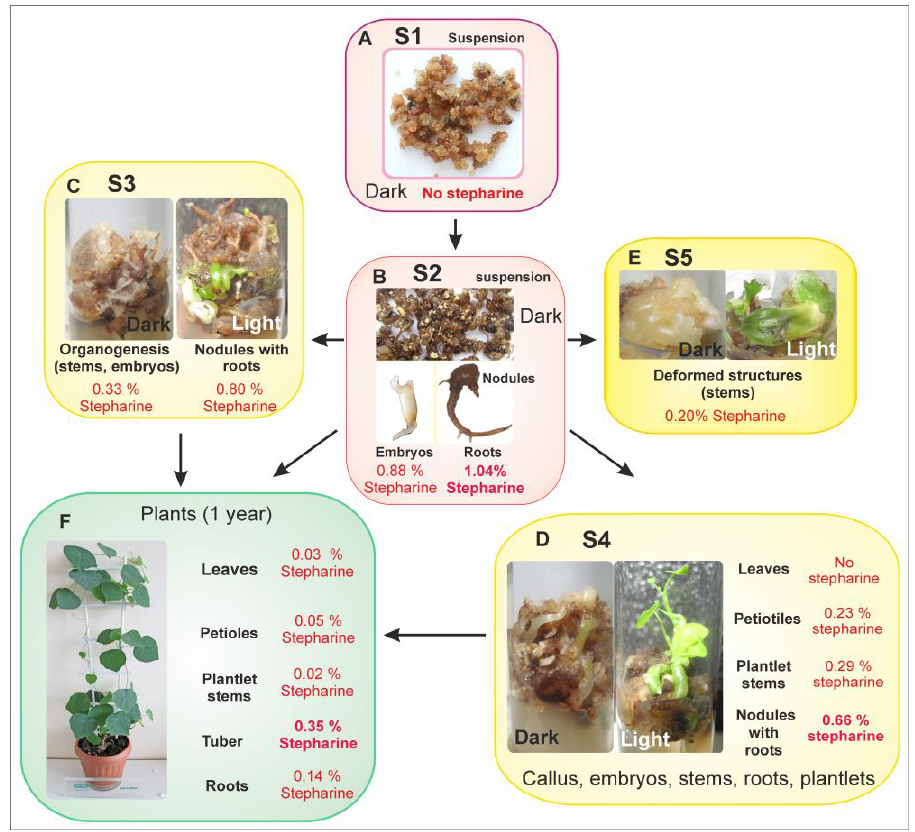
Figure 1. Callus lines and stepharine content in different organs and structures of S. glabra . ( A ) Proembryogenic S1 line. ( B ) Morphogenic S2 line. ( C ) Organogenic S3 line. ( D ) Organogenic S4 line. ( E ) Cell line S5 with deformed structures. ( F ) One-year-old plant.